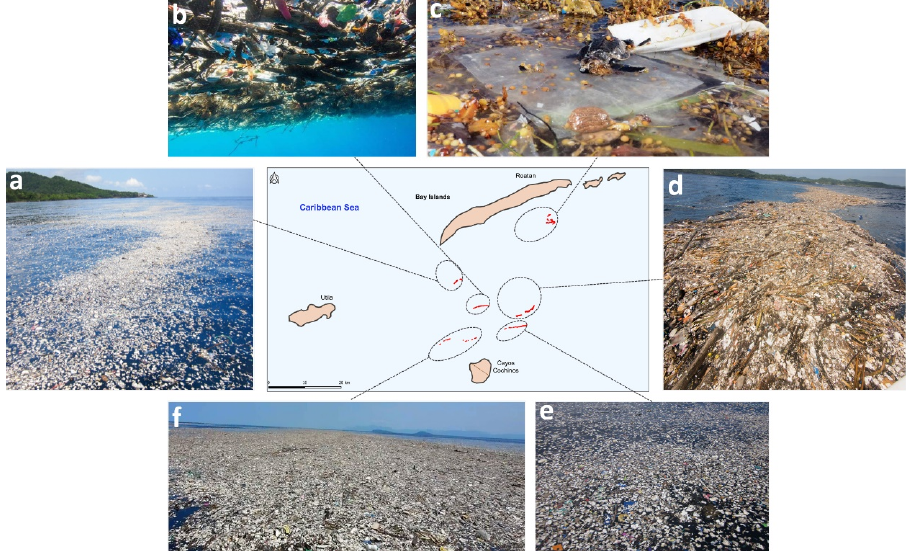
Figure 3. Detected plastic debris in satellite data (red dots in the map) and the corresponding in situ verification during the years of 2014–2018 around Bay Islands. ( a ) Collected in situ data southwest of Roatan island in September 2014. ( b ) In situ observations and underwater capture in November 2016. ( c ) Collected plastics in Roatan area. Sargassum macroalgae and a dead juvenile turtle were also recorded (October 2018). ( d ) Observed plastics during October 2016. Organic material (i.e., wood) was also recorded. ( e ) Observed plastic masses during November 2015. ( f ) Large plastic masses recorded in October 2017. Caroline Power acquired the photos of this figure.